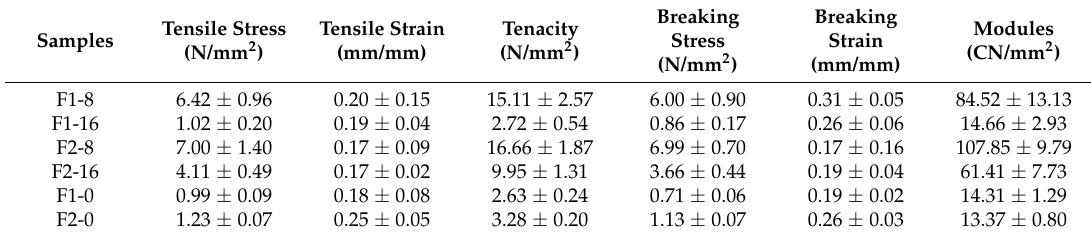
Table 2. Mechanical properties of samples.